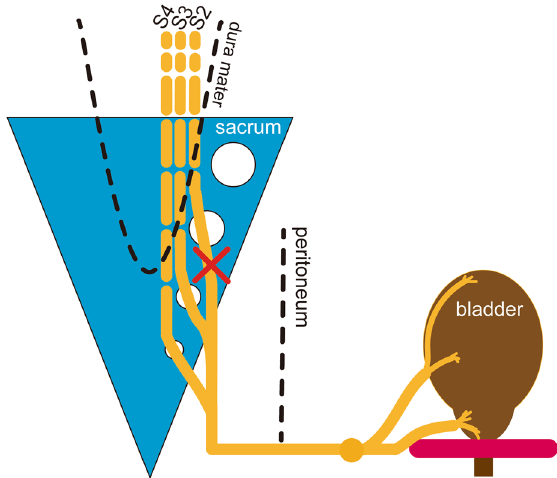
Figure 9. Schematic illustration of the establishment of SMI-DU rat